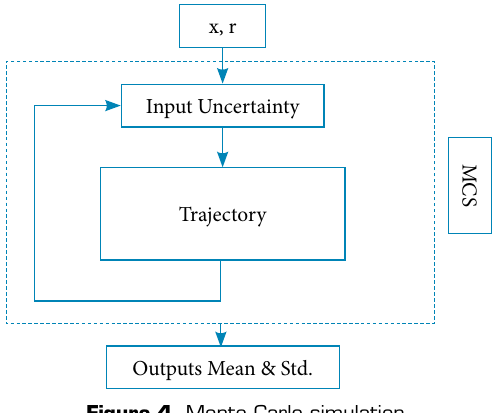
Figure 4. Monte Carlo